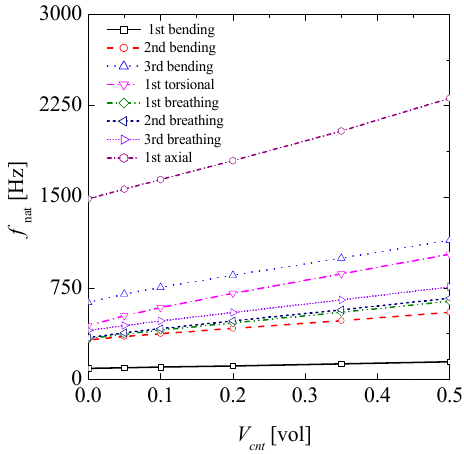
Figure 5. Natural frequencies as a function CNTs volume fraction. A hybrid composite drive shaft of stacking [±45° glass /0° carbon /90° glass ] was analyzed for length = 1730 mm, radius = 50.8 mm, and wall thickness = 2.032 mm, for modal analysis, where the volumetric concentration of nanoparticles was increased. The gradient of the lines shows the effect of CNTs volume fraction on the natural fre-